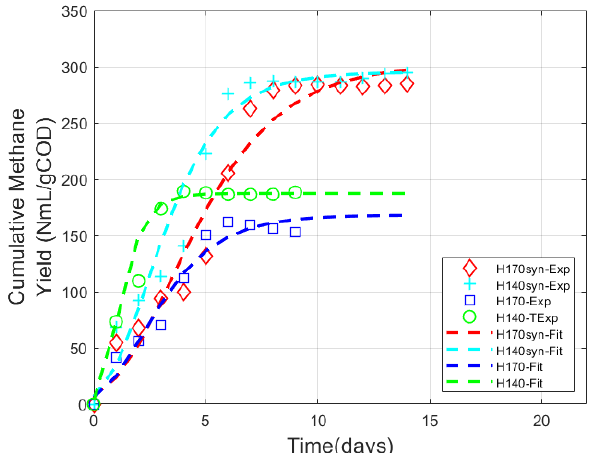
Figure 1. Cumulative methane yield of hydrolysate pretreated at 140 °C and 170 °C from AMPTS II fitted with modified Gompertz law.